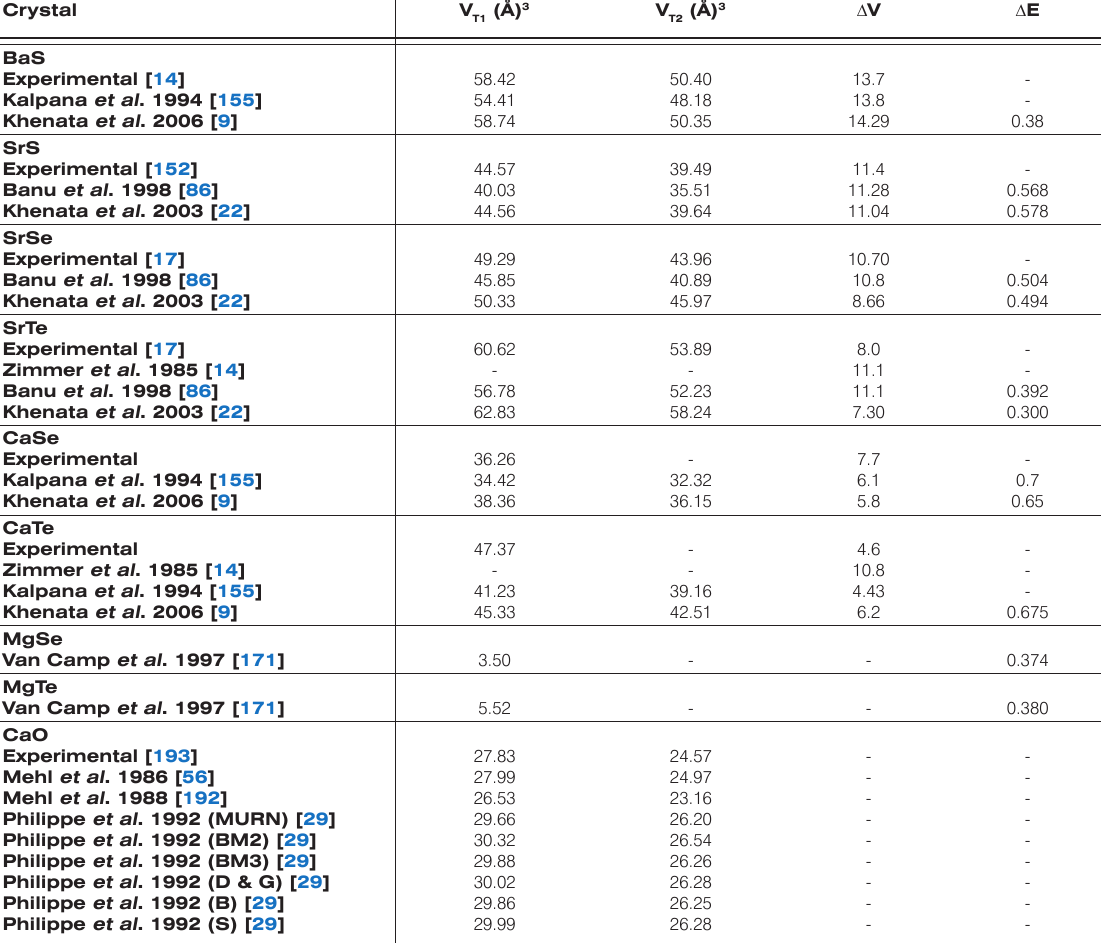
Table 5. Transition volumes (Å) 3 for B1 and B2 phase, volume change and energy change for alkaline earth chalcogenides.